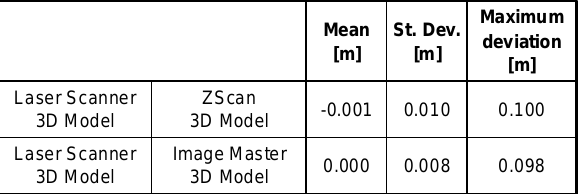
Table 4. Statistical values of the comparison between Laser